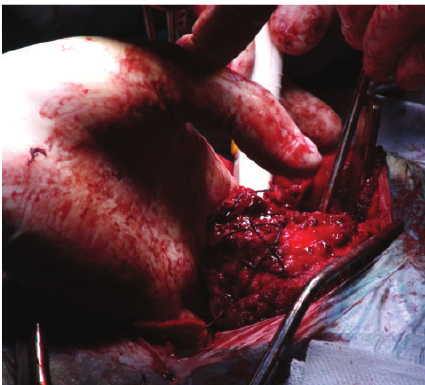
Figure 6: Kraske procedure providing access between mesorectum and presacral component of the tumor.